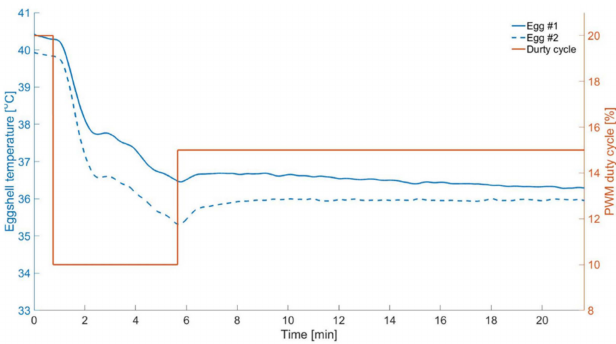
Figure 5. Step changes in the pulse width modulation (PWM) duty cycle (%) and the corresponding responses of the eggshell temperatures of two eggs in region II.